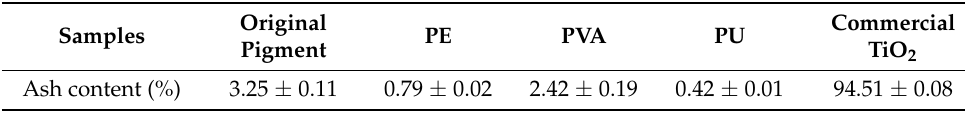
Table 3. Ash test results of raw materials and